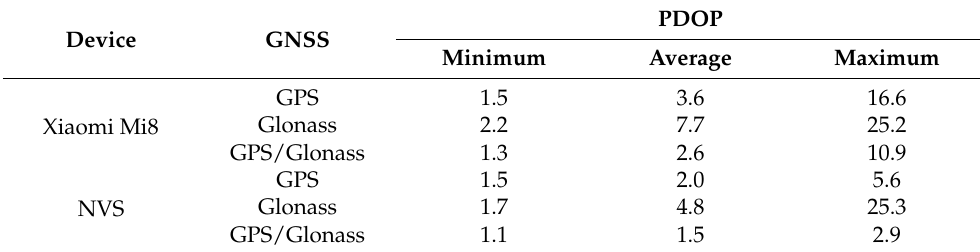
Table 2. Comparison between Xiaomi Mi8 and NVS satellite geometry.